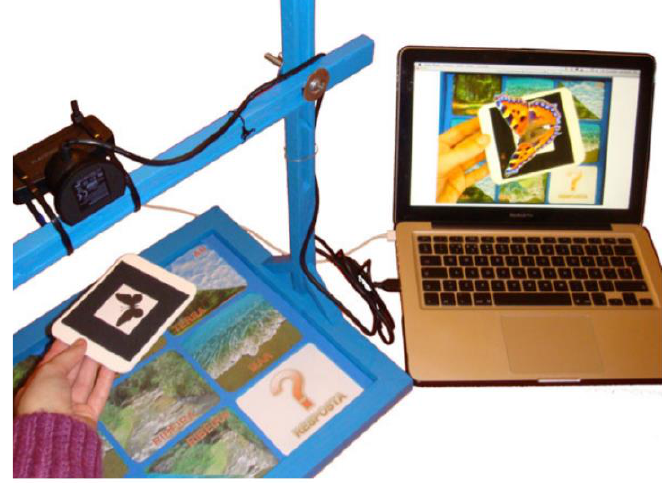
Figure 6. Proposed TUI system with a laptop [18].